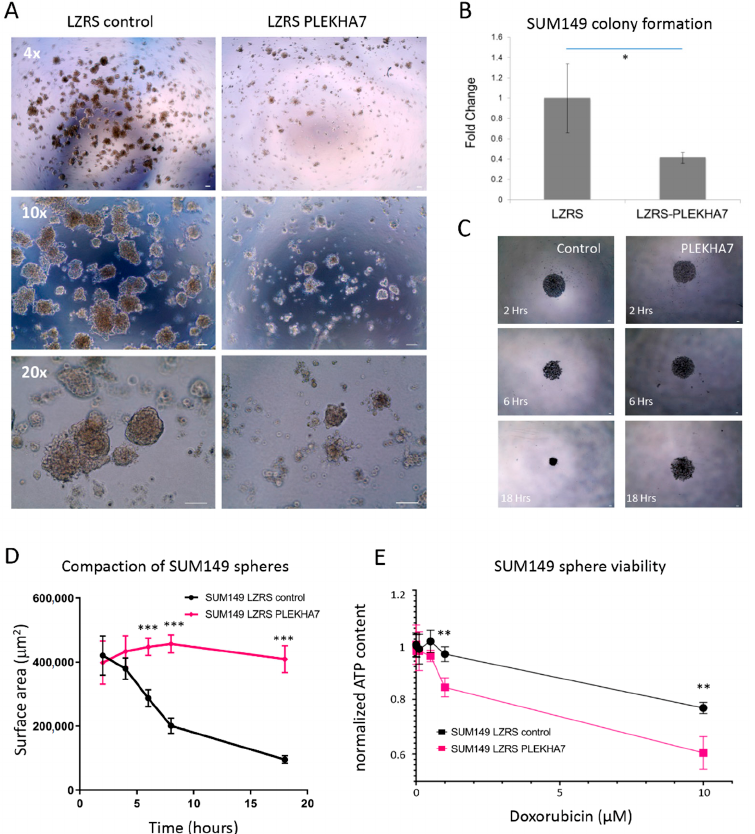
. Figure 3. Effects of PLEKHA7 re-expression on SUM149 cell growth and survival in 3D culture. ( A ) SUM149 LZRS ms neo (control) and SUM149 LZRS PLEKHA7 cells were grown in Matrigel for approximately two weeks. Representative images at 4 × , 10 × , and 20 × magnification are shown. Scale bar in each image = 100 µ m. ( B ) Quantification of SUM149 LZRS ms neo or SUM149 LZRS PLEKHA7 colonies from 3A are shown as the fold change from SUM149 LZRS ms neo. * indicates p < 0.05, Student’s t -test. ( C ) Representative images from SUM149 LZRS ms neo and SUM149 LZRS PLEKHA7 suspension cultures undergoing sphere compaction over 18 h. Images taken at 4 × . Scale bar in each image = 100 µ m. ( D ) A representative graph of SUM149 LZRS ms neo and SUM149 LZRS PLEKHA7 suspension cultures compacting into spheres over 18 h under ultralow attachment conditions. *** indicates p < 0.001, Student’s t -test ( p < 0.0001). ( E ) A representative graph of normalized ATP content produced by SUM149 LZRS ms neo and SUM149 PLEKHA7 spheres after treatment with various concentrations of DOXIL/doxorubicin for 72 h. ** indicates p < 0.01, Student’s t -test ( p = 0.002 for 1 µ M doxorubicin and 10 µ M doxorubicin). Each group was